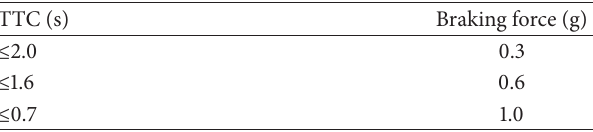
Table 1: AEB system braking